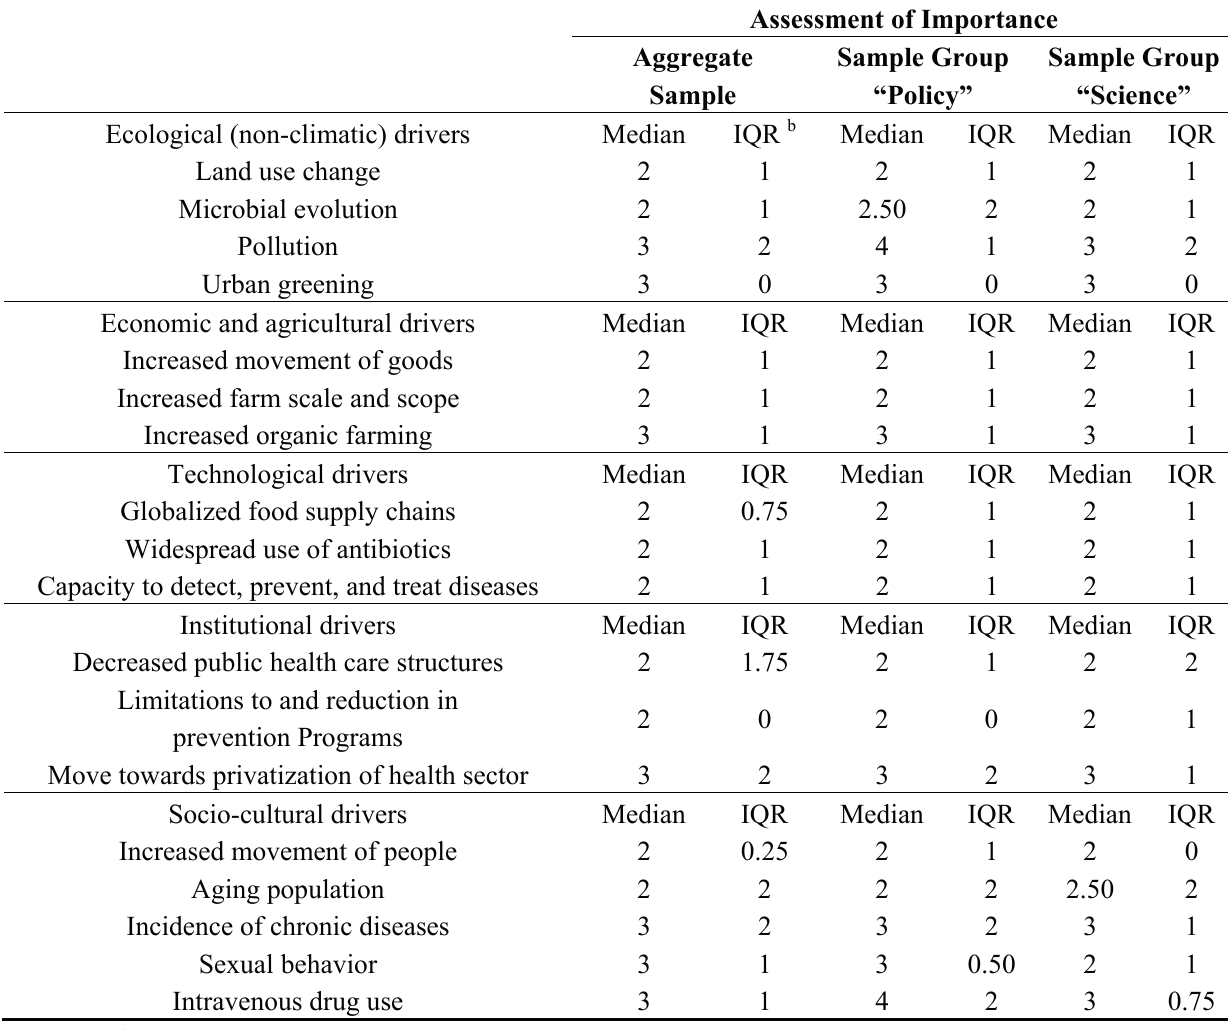
Table 2. Assessment results of the relative importance of non-climatic drivers of infectious disease risk, for the aggregate expert sample and for the two sample groups “Policy” and